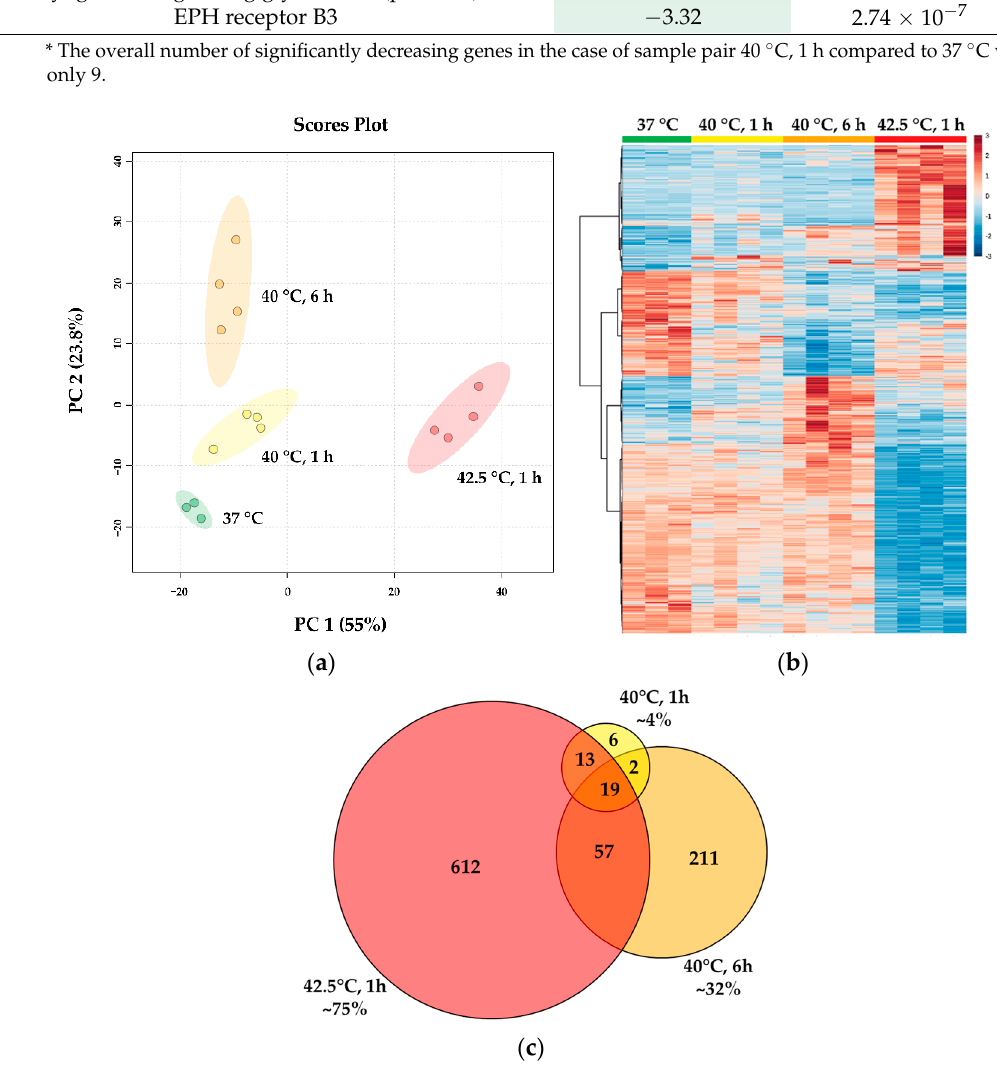
Figure 4. RNA sequencing data reveal distinct stress transcriptome upon different stress conditions. ( a ) RNAseq samples of CHO cells distinguished by principal component analysis. ( b ) Heatmap representation of hierarchical clustering. ( c ) Expression of total of 920 genes had significantly changed by different doses of mild (40 °C, 1 h and 6 h) and moderate (42.5 °C, 1 h) heat treatments in pairwise comparison to controls (37 °C)—shown in Venn diagram.